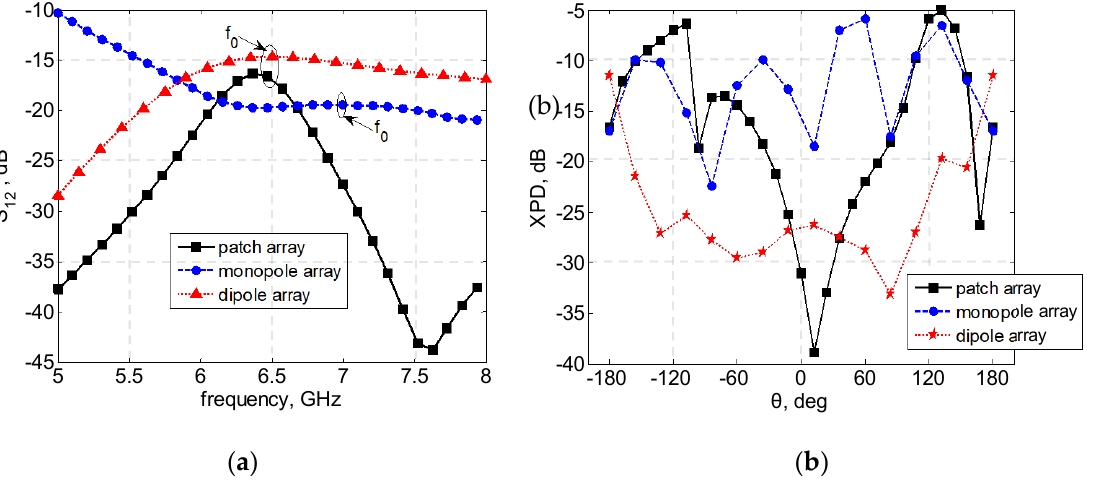
Figure 6. Performance comparison of the three antenna arrays. ( a ) Isolation and ( b ) XPD at the operation frequency of 6.4 GHz.